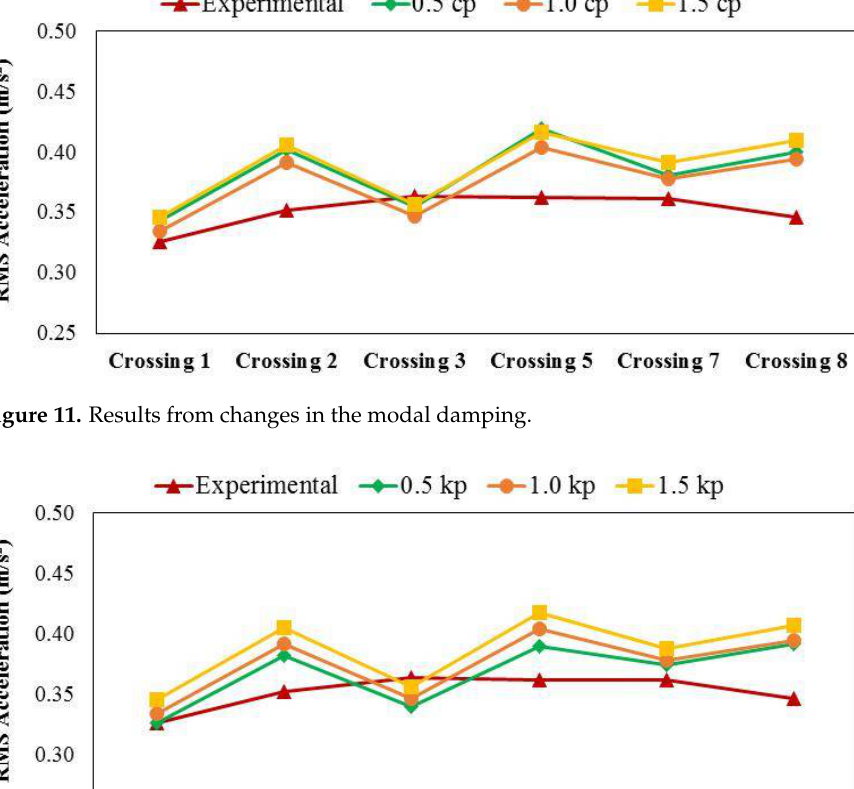
Figure 13. Results from changes in the modal mass. It can be noticed that among the three parameters, the modal mass of the pedestrians is the most influential one. By examining the plots of k p and m p together, it can be ob- served that a reduction in the natural frequency of the pedestrian body (caused by either a reduction in k p or increase in m p ) reduced the level of the response. This is explained by the closer proximity between the reduced natural frequency of the body and the natural frequency of the structure. Van Nimmen et al. [26] explained this effect by an association with the behavior of tuned mass dampers, and the results shown here are consistent with this feature. This calls attention to the fact that if the natural frequency of a structure were closer to the natural frequency of the body, it is expected that the difference between in- teraction and force models would be more prominent than that in the case under study. 3.3. Effect of the Number of Pedestrians in the Group By taking the UK NA to BS EN 1991-2 as a reference [14], the number of pedestrians to be considered in a group can vary from 2 (seldomly used, rurally located footbridges) to 16 (footbridges that serve as primary access to assembly facilities). Then, bearing in mind the differences previously observed in the modeling effect between force models and dynamic systems in terms of vibration response from single and group crossings, it is worth investigating the effect that the number of pedestrians may present in terms of the difference between the (code) approach of modeling the action of pedestrians as force-only and as dynamic systems interacting with the structure.